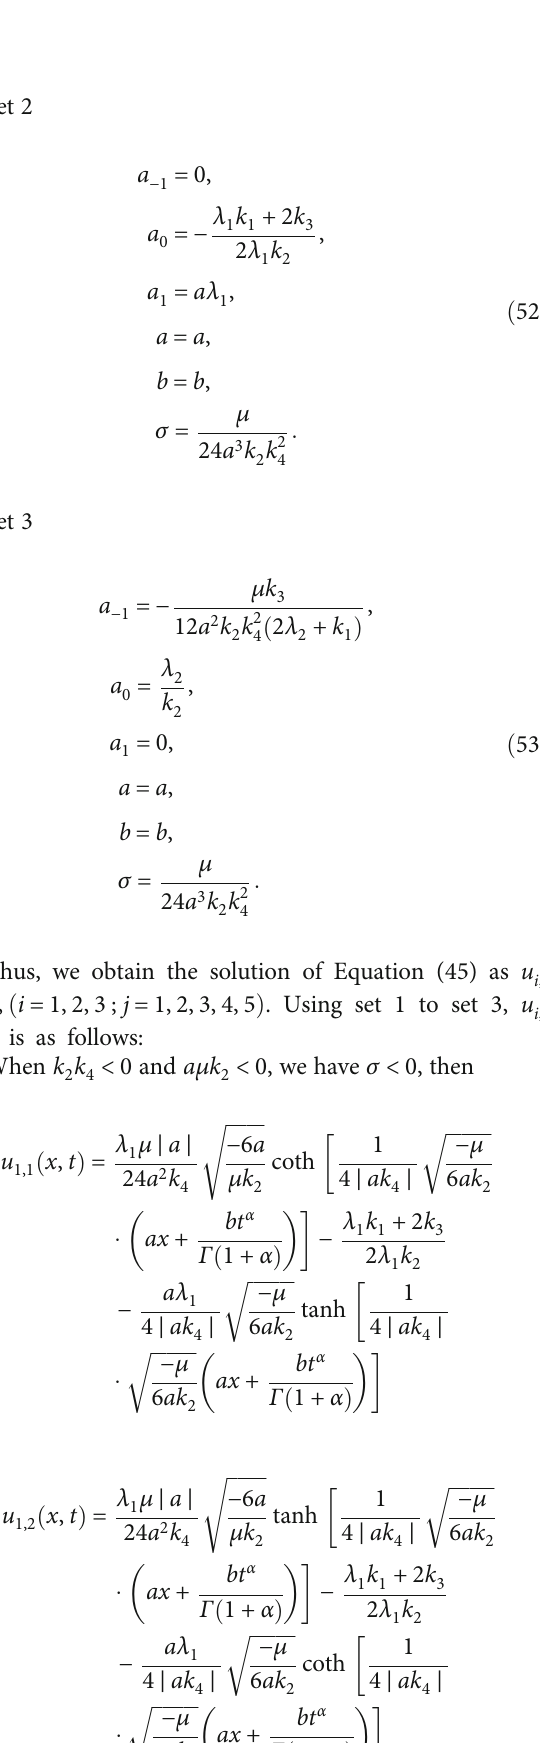
ffiffiffiffiffiffiffi